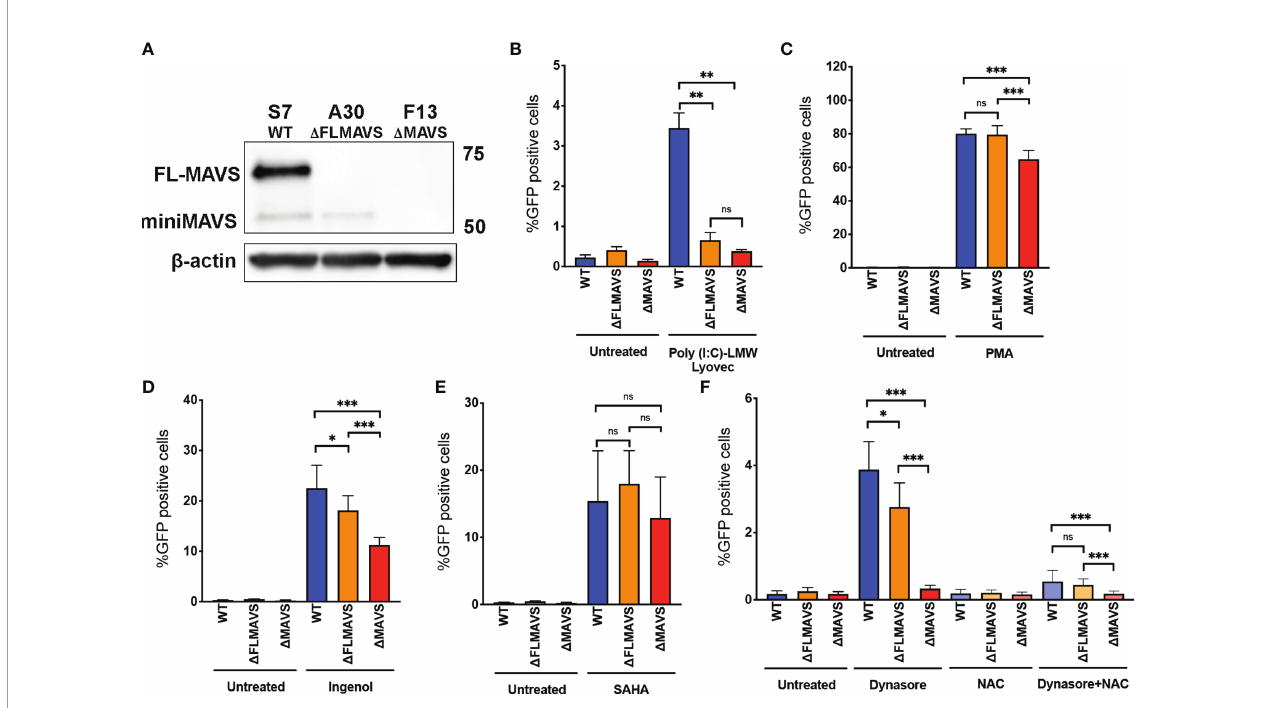
FIGURE 7 | miniMAVS plays a role in the ROS-mediated reactivation of latent HIV-1. (A) Immunoblot of J-Lat CRISPR clones S7, A30, and F13. J-Lat CRISPR clones were incubated with RIG-I agonist Poly(I:C) LMW Lyovec (B) , PMA (C) , Ingenol (D) , SAHA (E) or Dynasore in the presence or absence of NAC (F) . % GFP positive cells were measured by fl ow cytometry. Data are represented as mean ± SD. (*p < 0.05; **p < 0.01; ***p < 0.001; ns, not signi fi